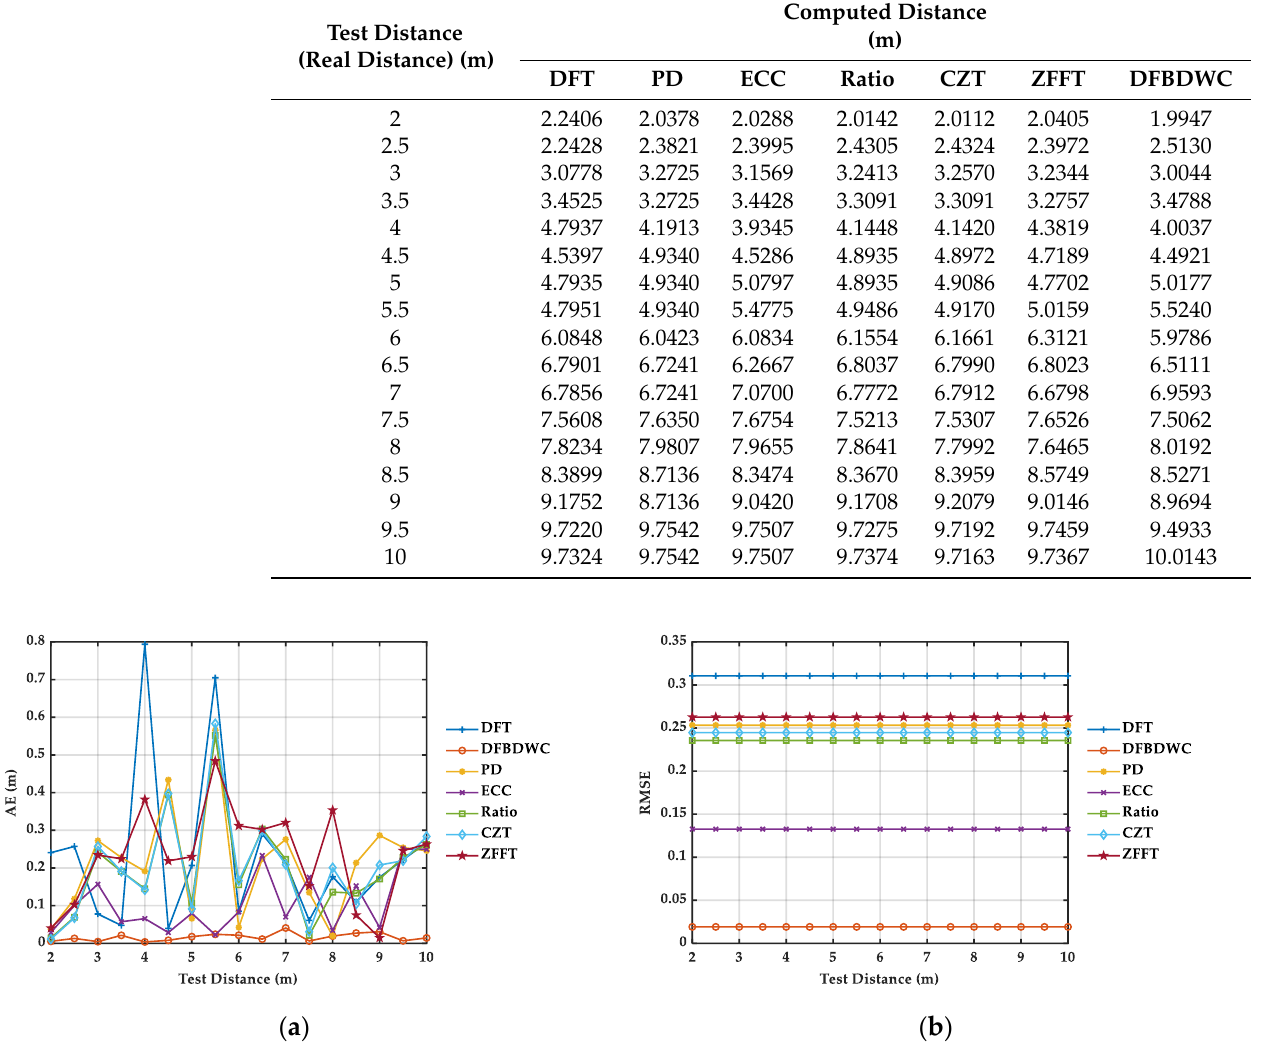
Figure 10. Experimental results of seven algorithms comparison at different distances. ( a ) is AE . ( b ) is RMSE. Table 6. Maximum and minimum AE of each